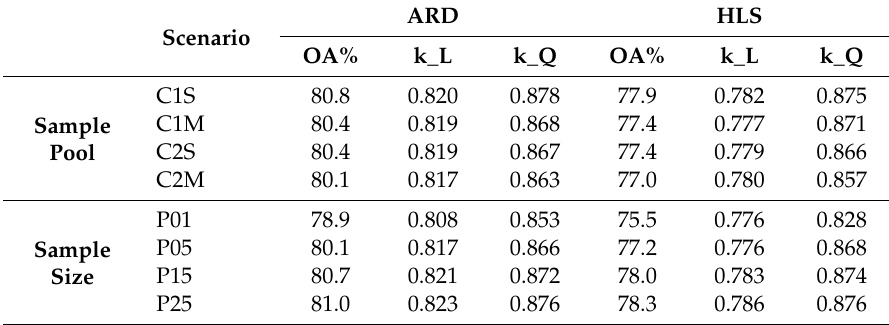
Table 11. Pixel-based comparison between 2016 predicted land cover maps and CDL, summarized by sample pools and sample